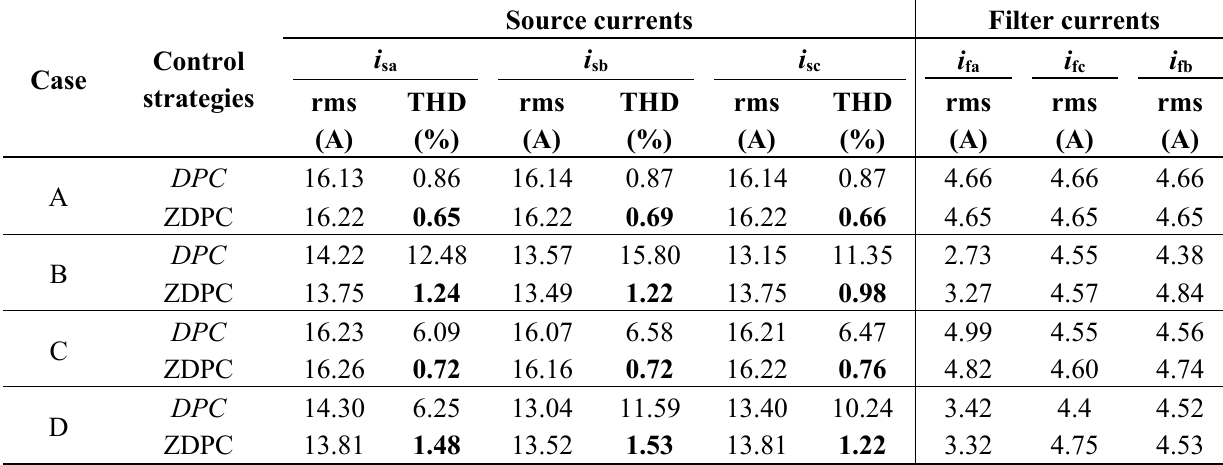
Table 3. Simulation results for DPC and ZDPC strategies under different grid conditions (A, B, C,